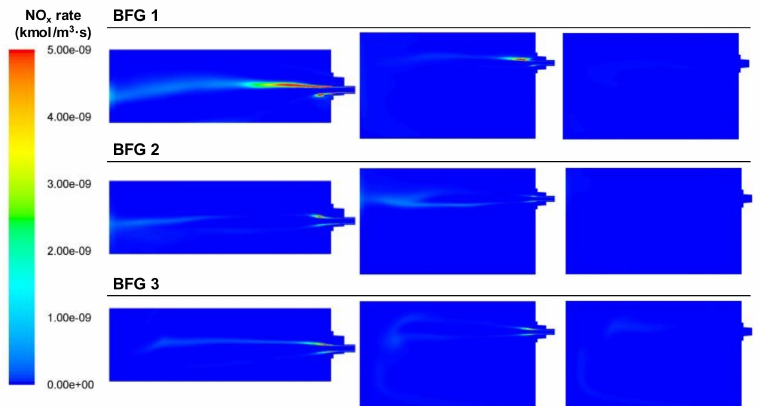
Figure 15. Contour plots of thermal NOx rate generation for the BFG cases in the XZ1, XY1, and XY2 planes.